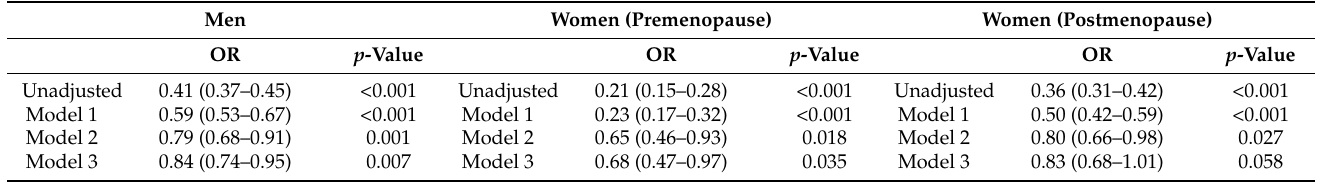
Figure 2. Prevalence of DM according to RGS (GS/BMI) quartiles. Table 2. Association between RGS (per 0.1 kg) and the prevalence of DM in Koreans using multivari- ate logistic